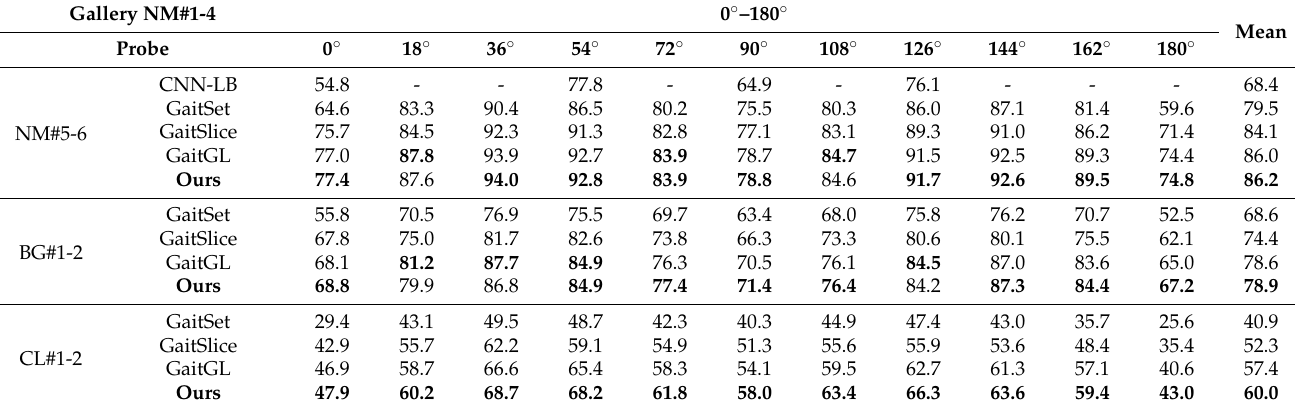
Table 4. Averaged rank-1 accuracies on CASIA-B under ST setting, excluding identical-view